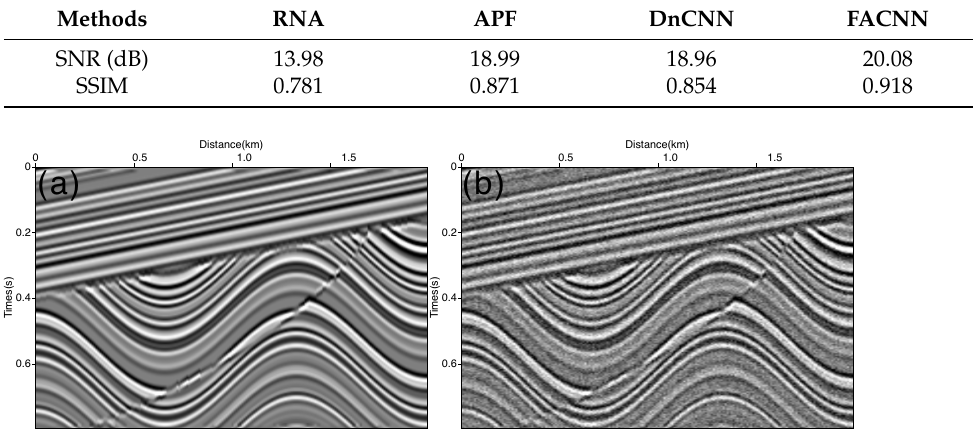
Table 2. The comparison of the SNR and SSIM for different methods.